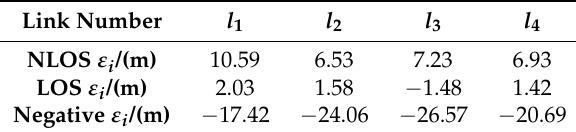
Table 2. Ranging errors in the noncooperative scenario.